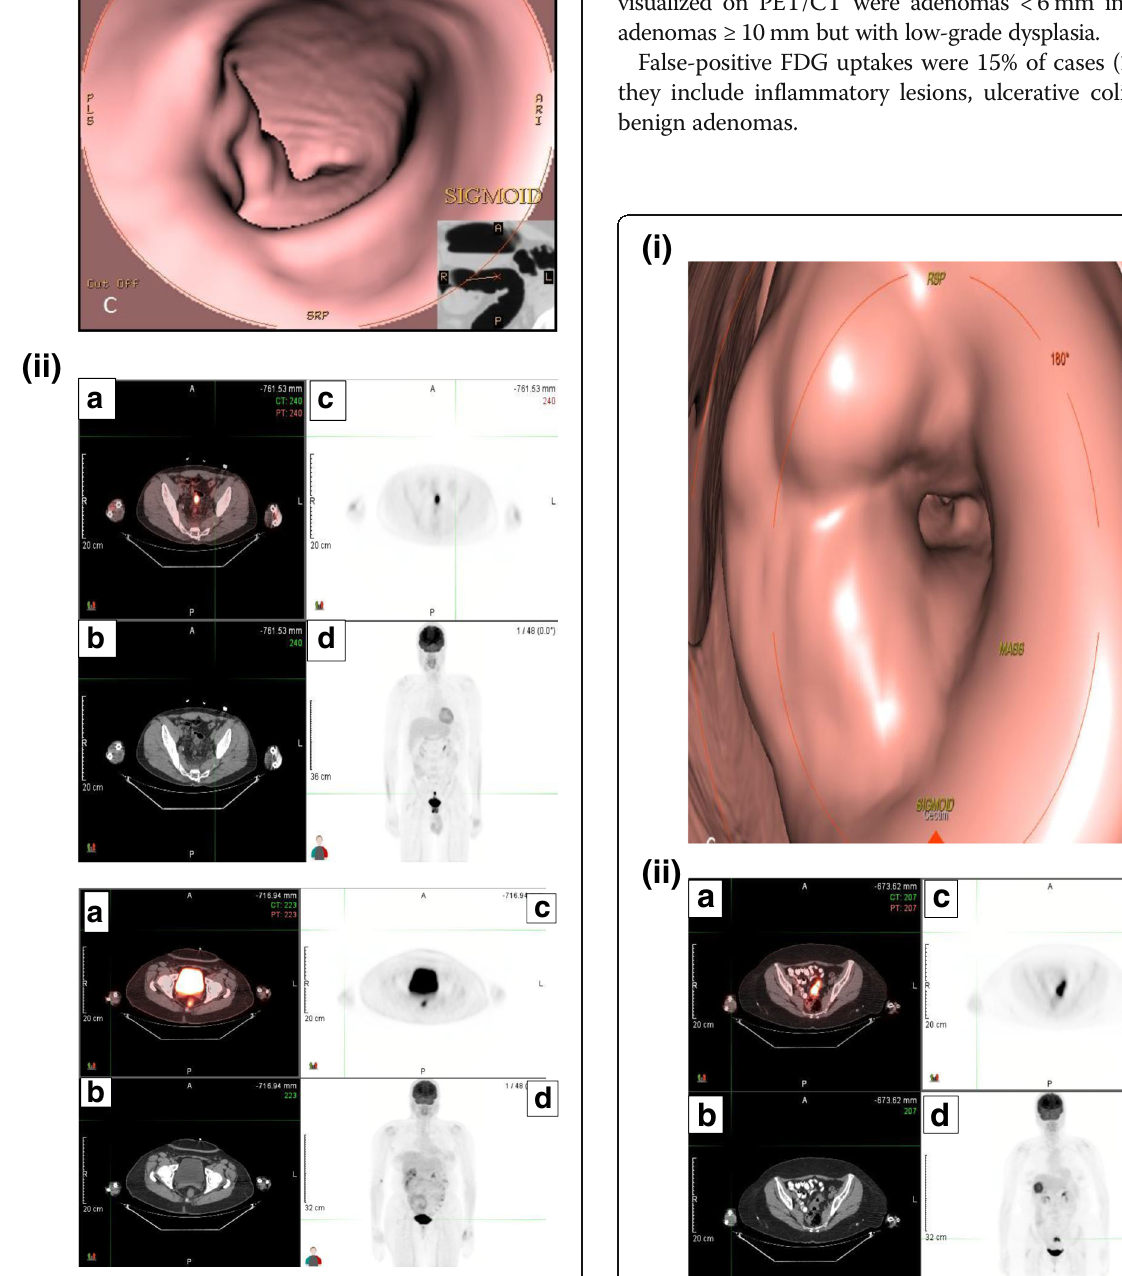
Fig. 1 A 69-year-old male. i CT colonography revealed a rectosigmoid polyp. ii FDG avid pathologically proved high-grade dysplastic rectosigmoid polyp with SUVmax 14.2. a Axial PET/CT. b Axial CT. c , d PET